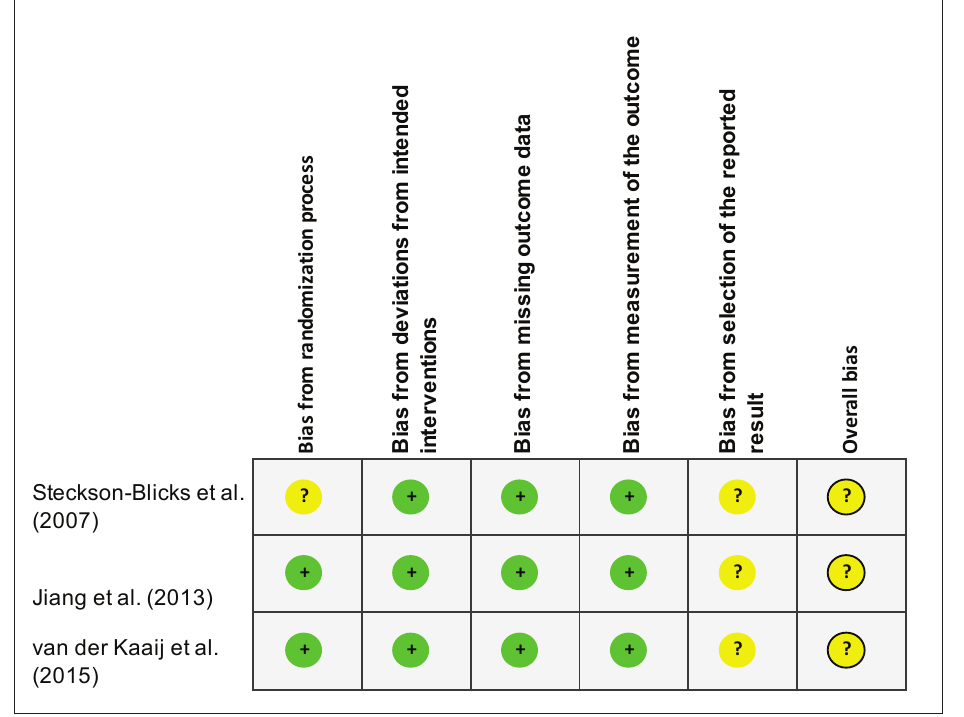
Figure 2. Risk of bias summary of studies included in the meta-analysis.